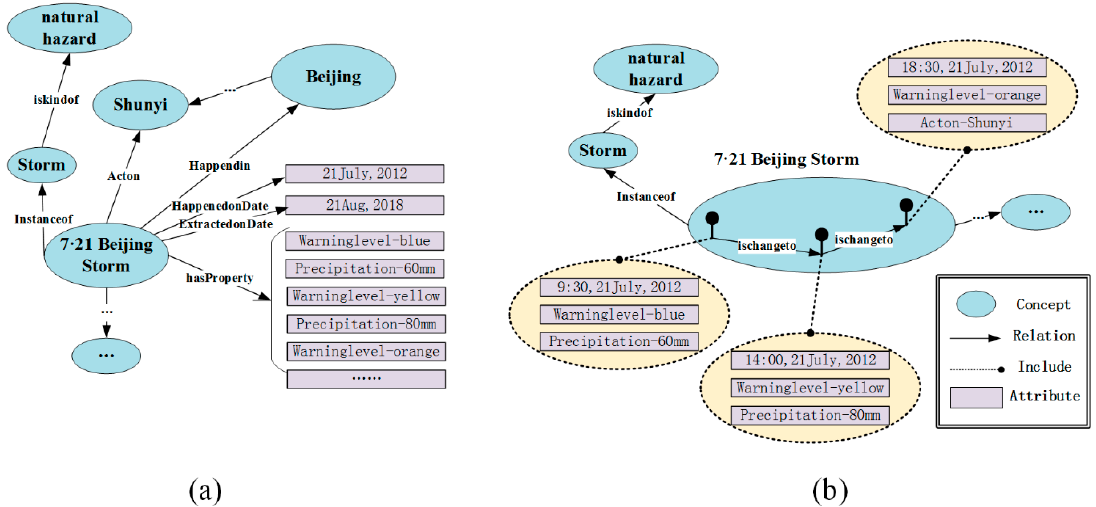
Figure 1. Different geographic knowledge representations of the 7 · 21 Beijing Storm. ( a ) Knowledge graph data structure and ( b ) procedural knowledge data structure.